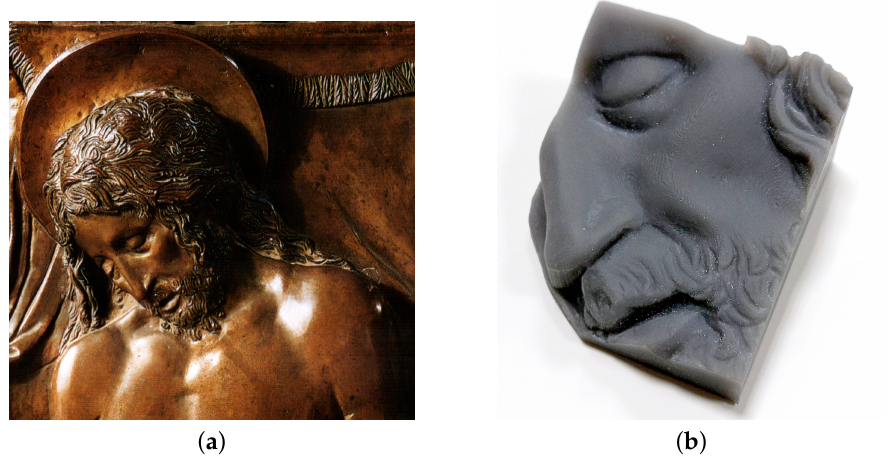
Figure 10. ( a ) Detail of the Dead Christ bronze relief by Donatello. ( b ) 3D printed replica of the acquired ROI of the face.